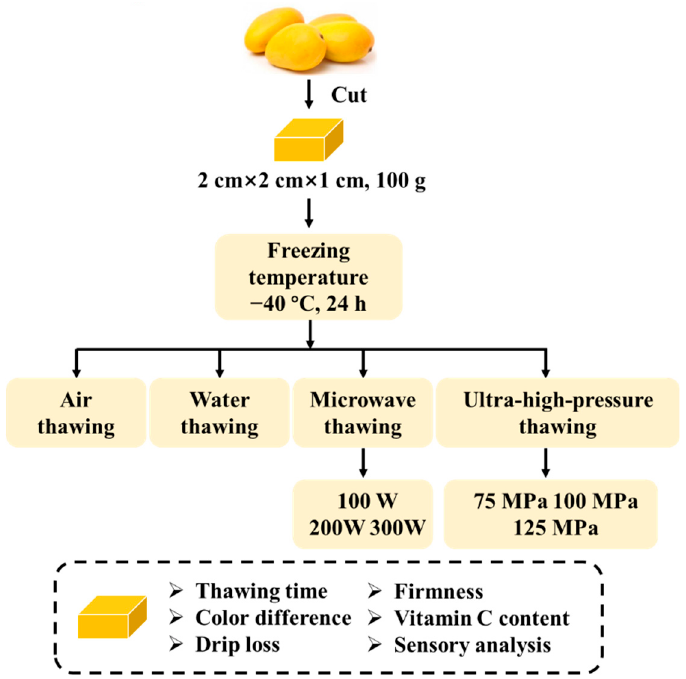
Figure 1. The flow chart of the experimental design.